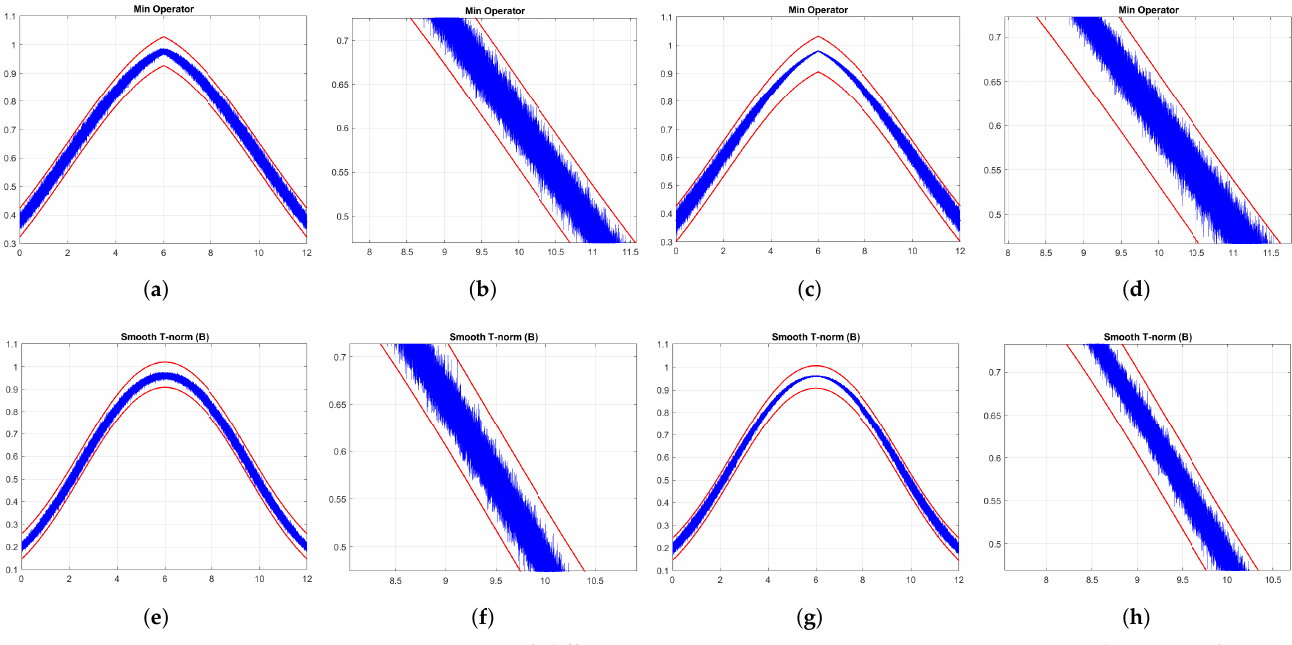
Figure 2. Impacts of different t-norm operators. ( a ) m + noise . ( b ) Zoomed in. ( c ) std + noise . ( d ) Zoomed in. ( e ) m + noise . ( f ) Zoomed in. ( g ) std + noise . ( h ) Zoomed in.